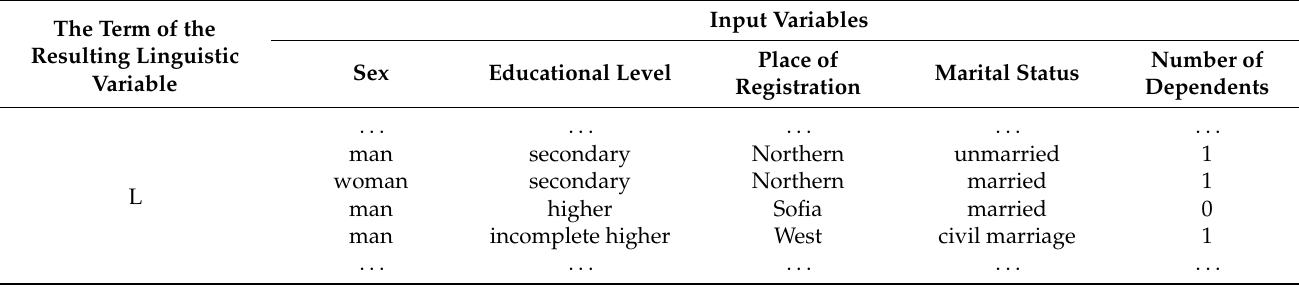
Table A3. Fragment of the rules base for qualitative variables of the intermediate integrated indicator on the borrower’s personal data based on the results of neural